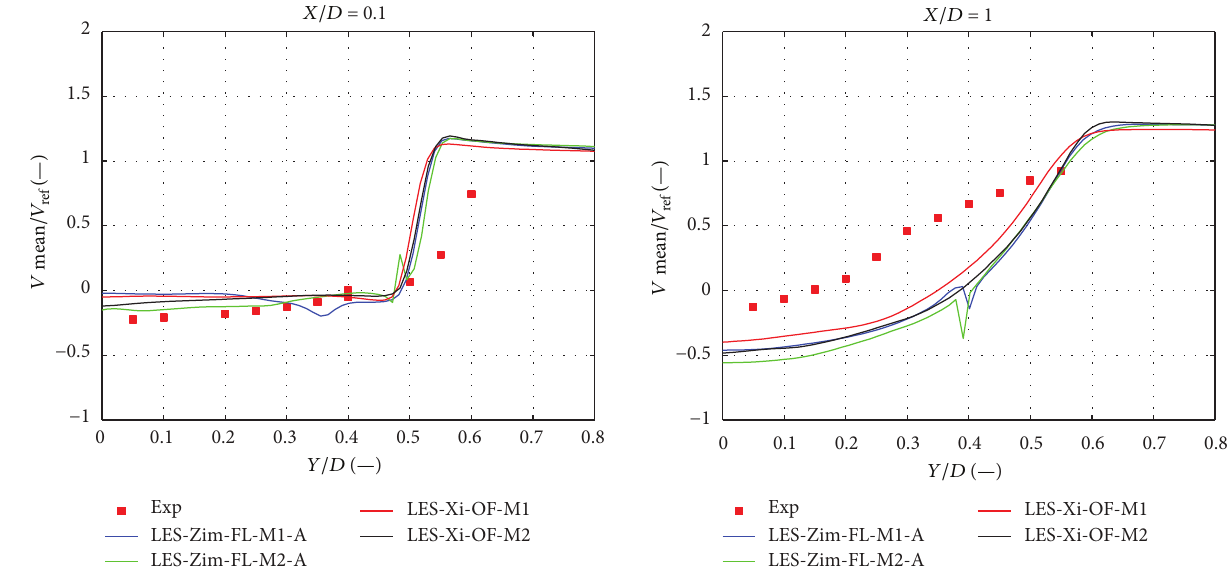
Figure 15: Mean axial velocity profiles with OpenFOAM and Fluent